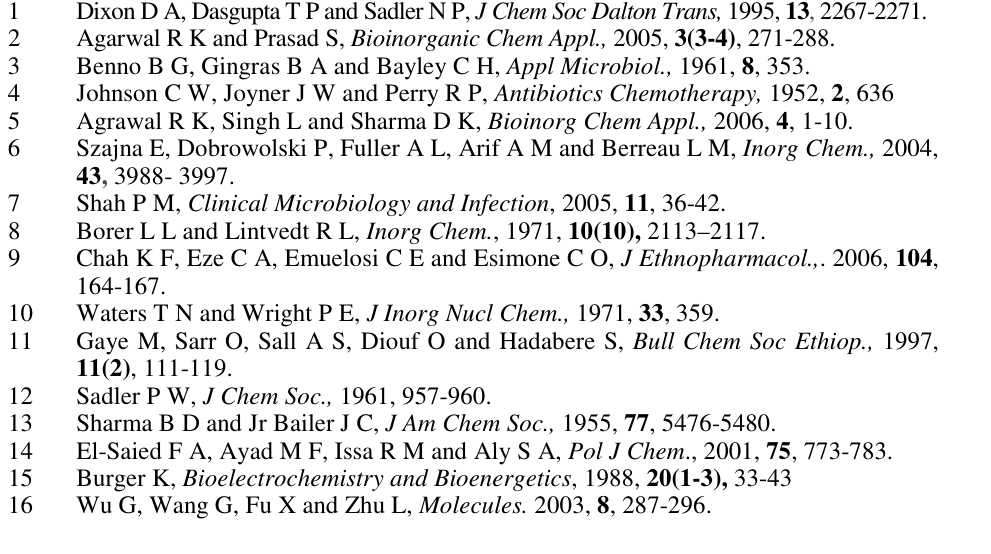
Table 8. Antimicrobial properties of DBCT, BBCT and their metal complexes Mean Inhibition Zone Diameter (IZD) (